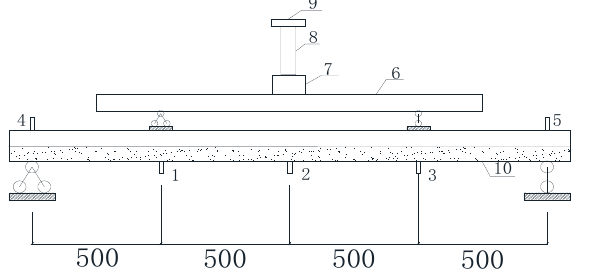
Figure 17. The lay − out diagram of the test loading device. 1–5—displacement meter; 6—distribution beam; 7—sensor; 8—jack; 9—reaction frame; 10—composite slab.